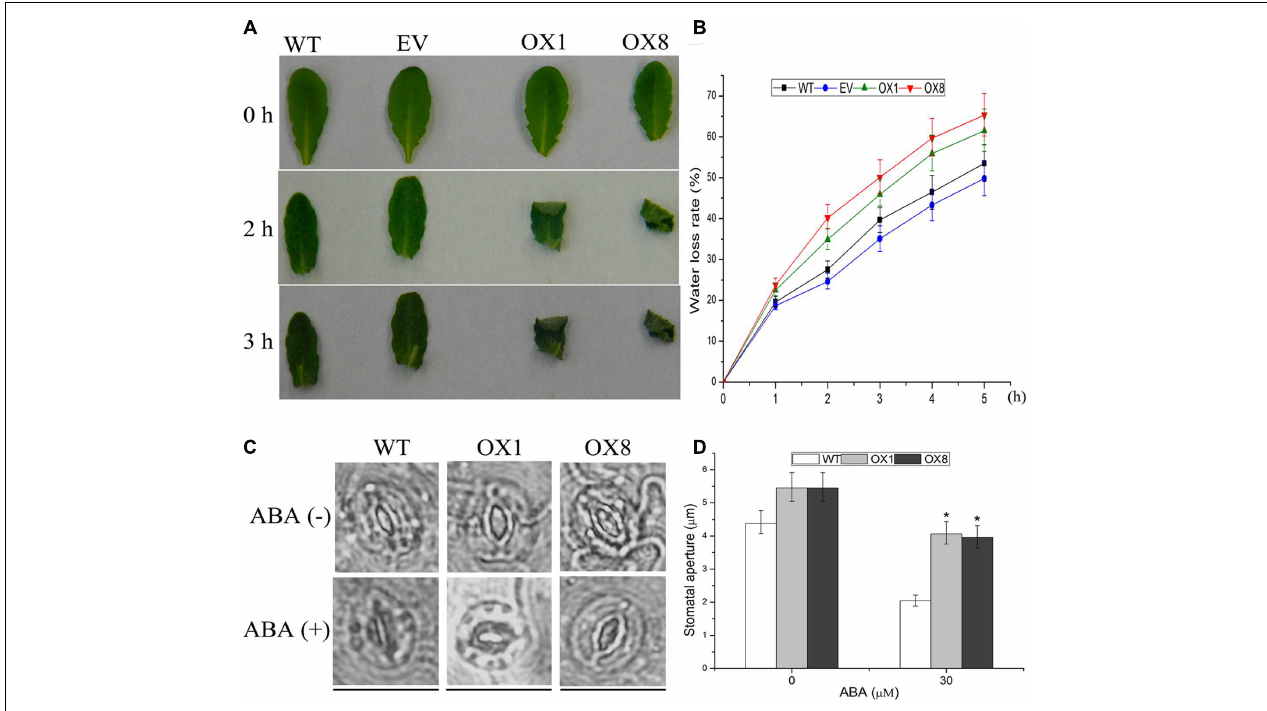
FIGURE 5 | Response of TaNAC2D -OX plants to dehydration and ABA-mediated stomatal closure. (A) Phenotypes of leaves under dehydration stress for 0, 2, and 3 h. (B) Water loss rate of WT, EV, and OXs. Data are means ± SE of three independent experiments ( n = 10). (C) Guard cells of 35-day-old soil-grown WT and OXs treated with or without 30 µ M ABA for 1 h. Scale bars = 30 µ m. (D) Quantitative analysis of the size of stomatal aperture. Data are means ± SE ( n = 50). Asterisks indicate significant differences from WT ( ∗ P <